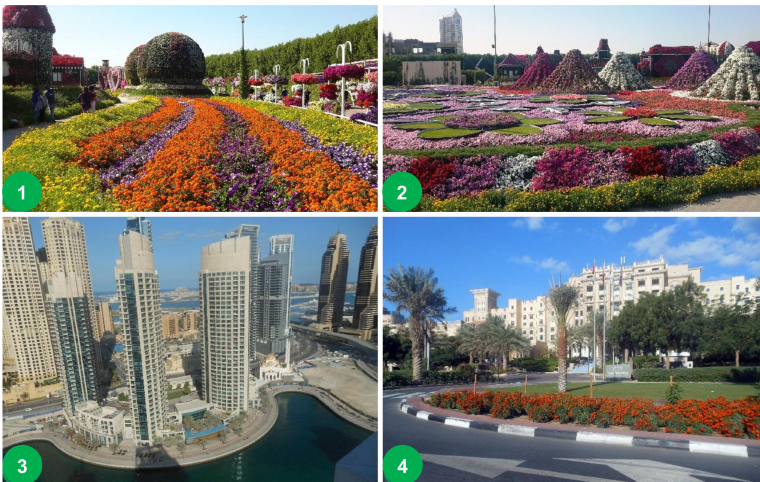
Figure 3. Dubai, UAE: ( 1 ) Dubai Miracle Garden with surrounding ‘green’ wall barrier in background, ( 2 ) Dubai Miracle Garden with integrated shading structures, ( 3 ) Dubai Marina with high-rise buildings and green rooftops, ( 4 ) Dubai Streetscape (Photographs taken by A. Russo, 13 November